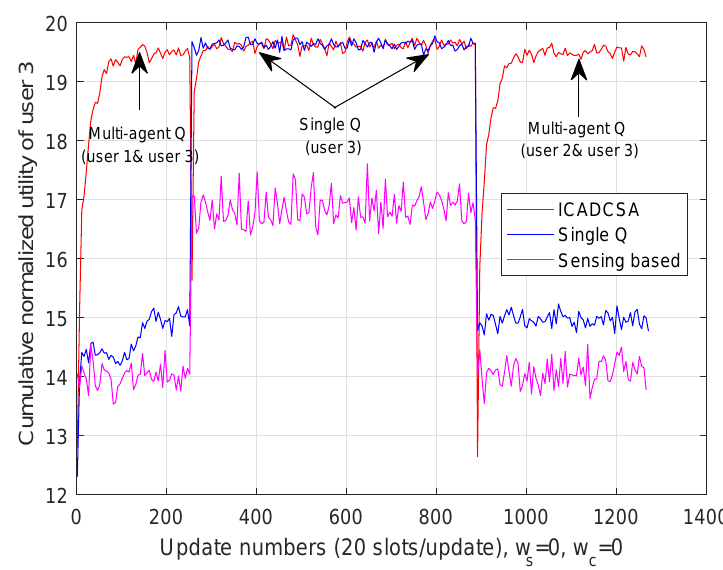
Figure 10. Cumulative normalized utility of User